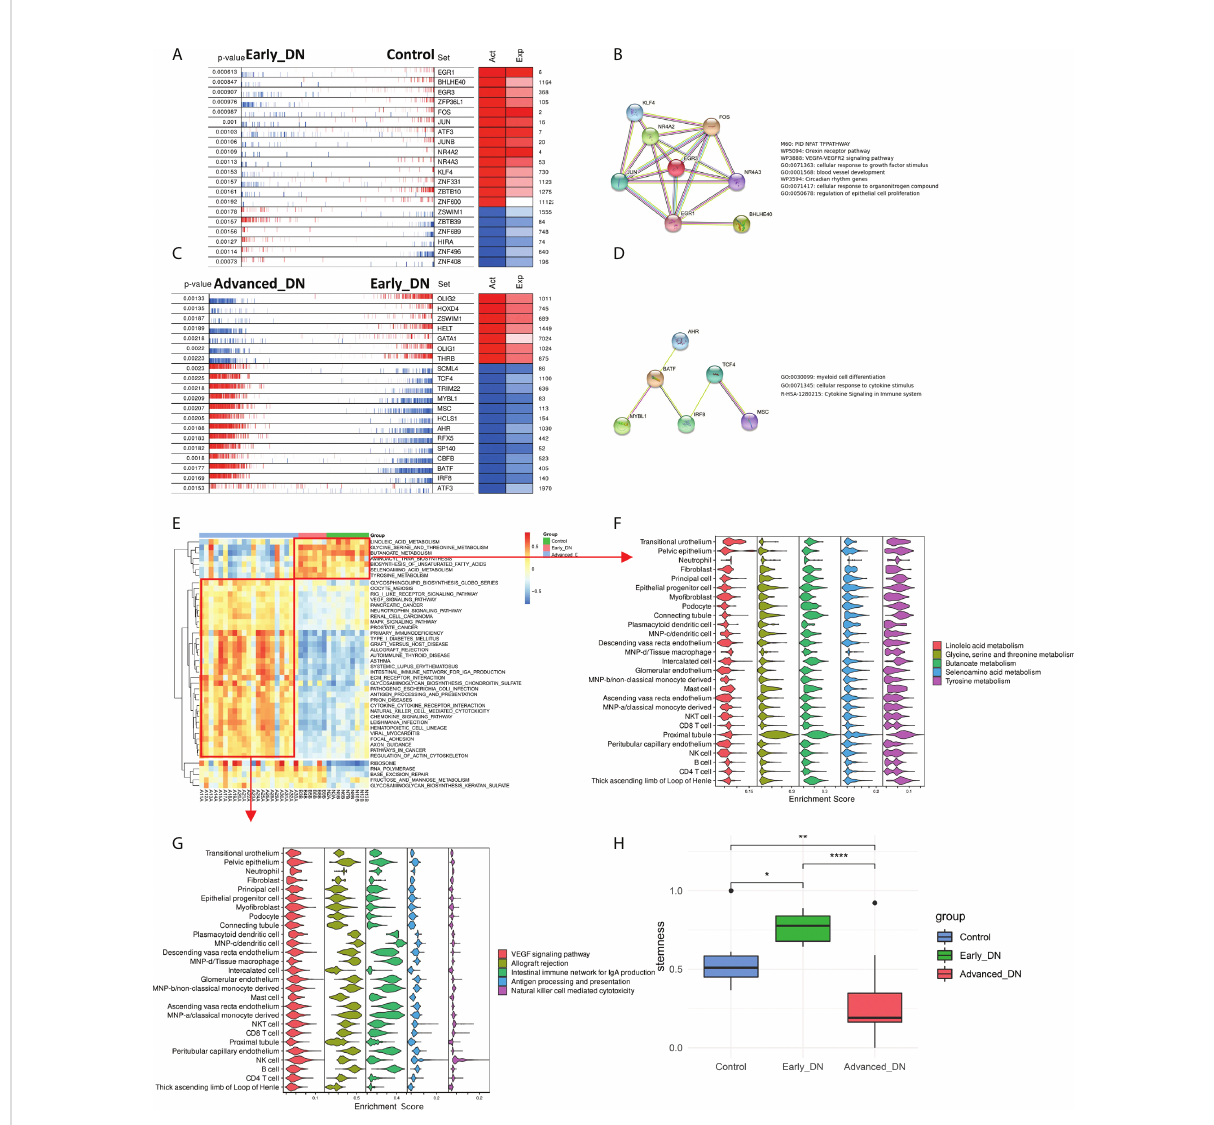
FIGURE 3 Analysis of master regulators in the occurrence and development of DN. (A) Analysis of control to Early DN master regulators. (B) The results of PPI regulatory network and functional enrichment analysis of the master regulators from Control to Early DN. (C) Analysis of master regulators from Early DN to Advanced DN. (D) The PPI regulatory network and functional enrichment analysis results of master regulators from Early DN to Advanced DN. (E) Results of GSVA enrichment analysis in three grouped DN samples of the MSIGDB C2 KEGG gene set. (F) Localization of signaling pathways enriched in Control and Early DN samples at the single-cell level. (G) Localization of signaling pathways enriched in Advanced DN samples at the single-cell level. (H) Stemness Comparison. ***P < 0.001, **P < 0.01, *P <